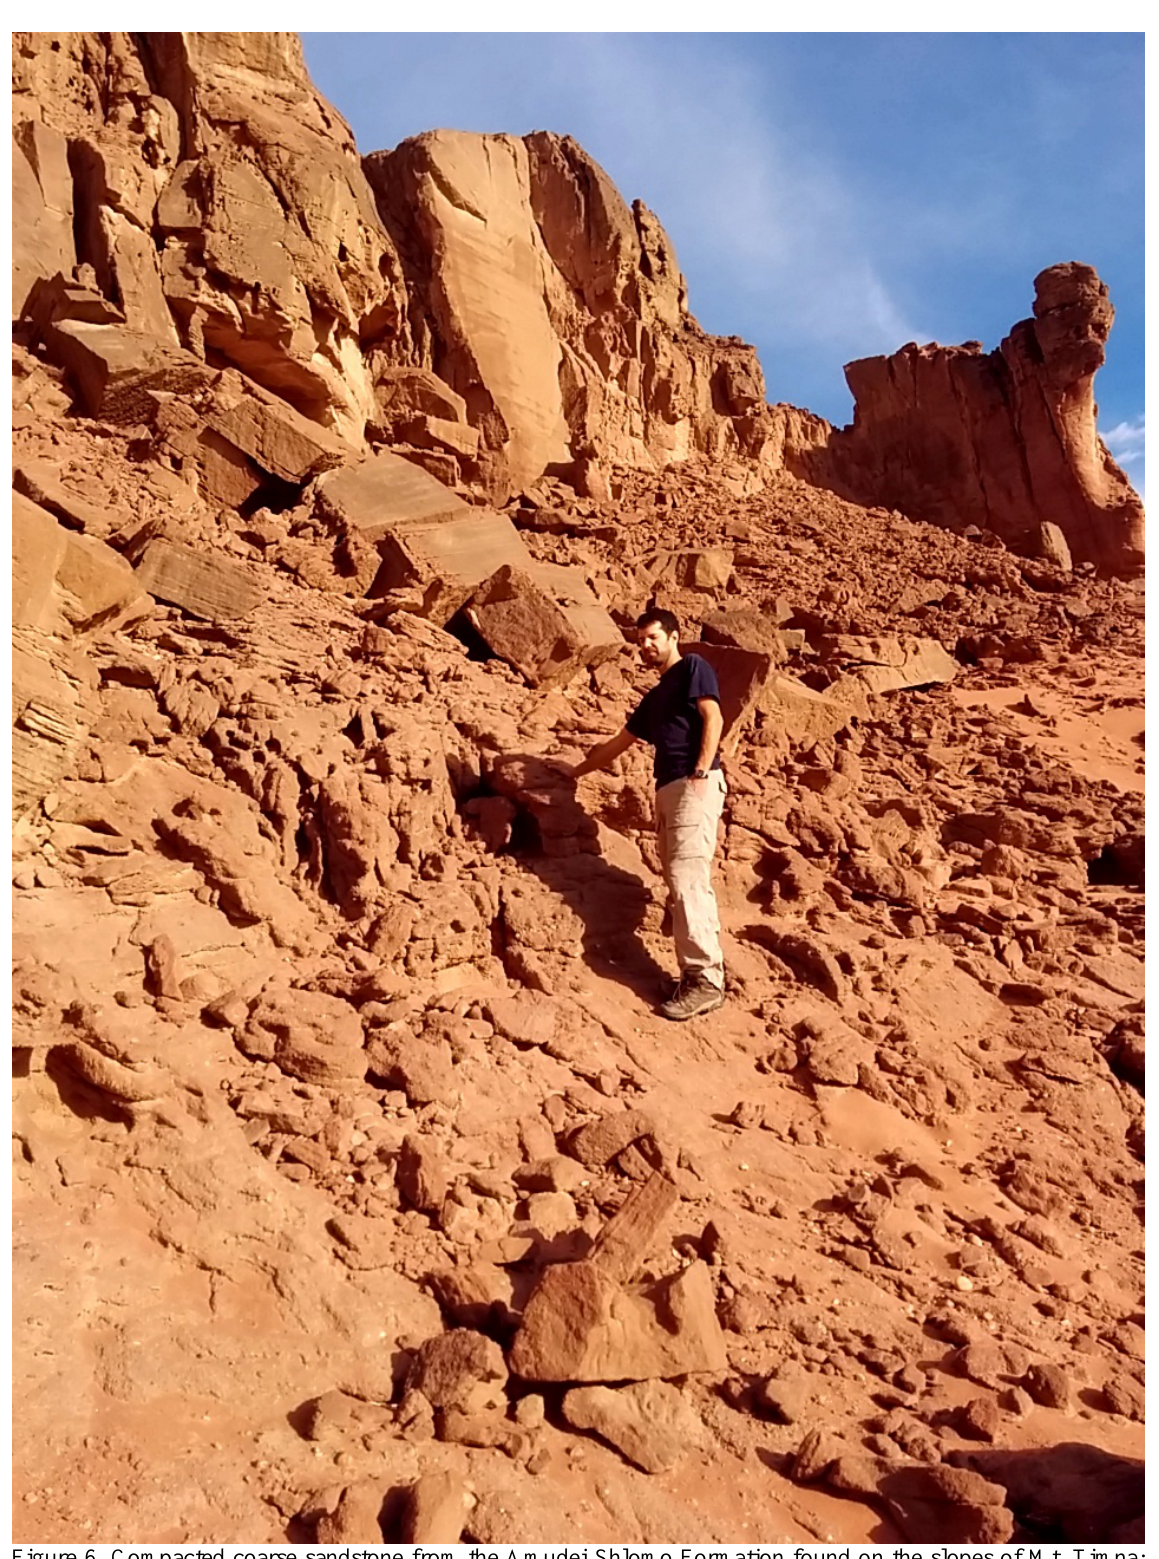
Figure 6. Compacted coarse sandstone from the Amudei Shlomo Formation found on the slopes of Mt. Timna; looking east. The photo’s location is marked as #1 in Figure